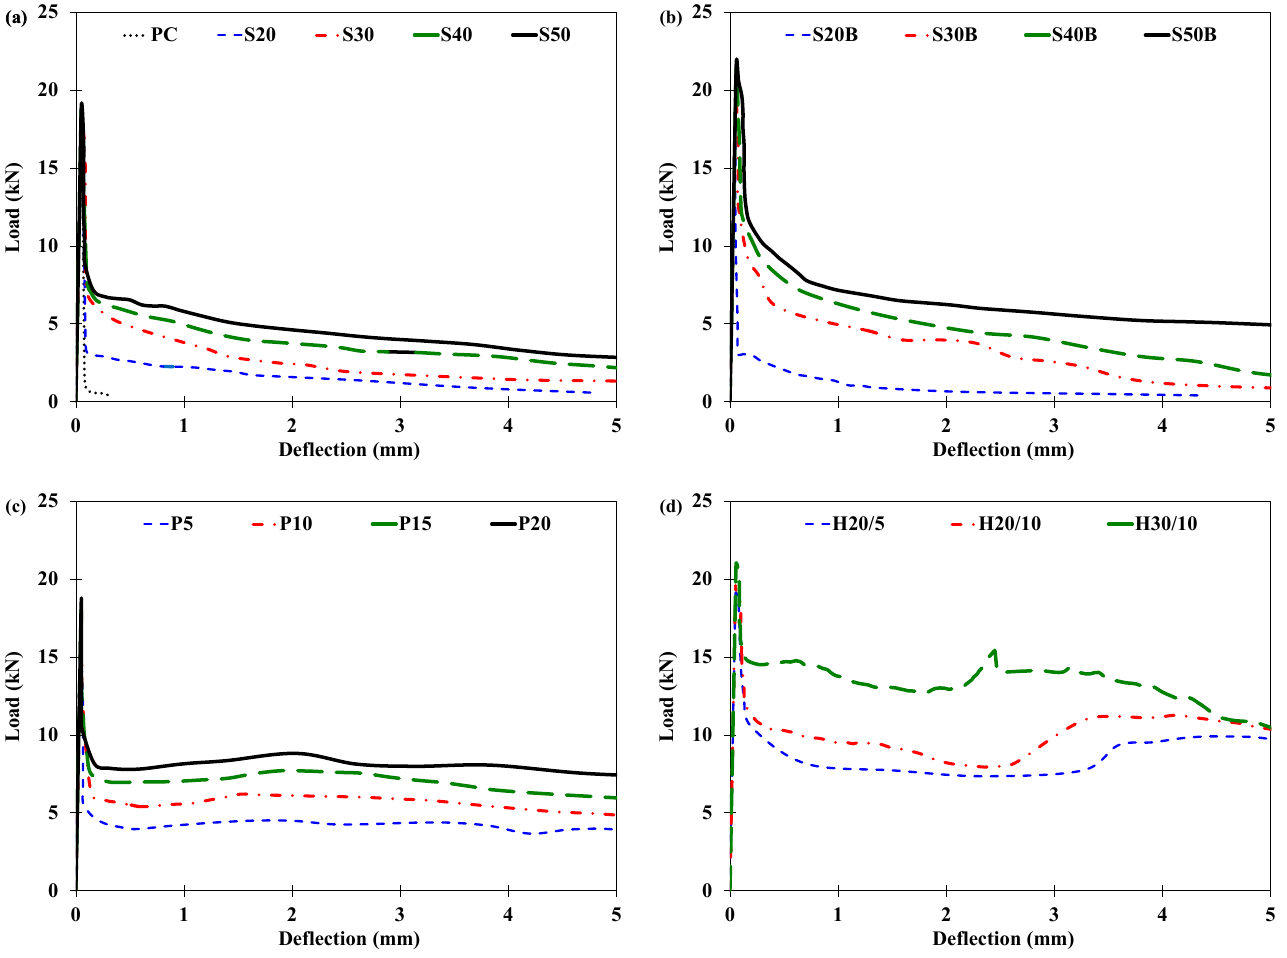
Figure 7. Load ‐ deflection curves in flexure for specimens incorporating ( a ) straight steel fibers, ( b ) bundled steel fibers, ( c ) PP fibers, ( d ) hybrid fibers (bundled steel fibers and PP fibers).